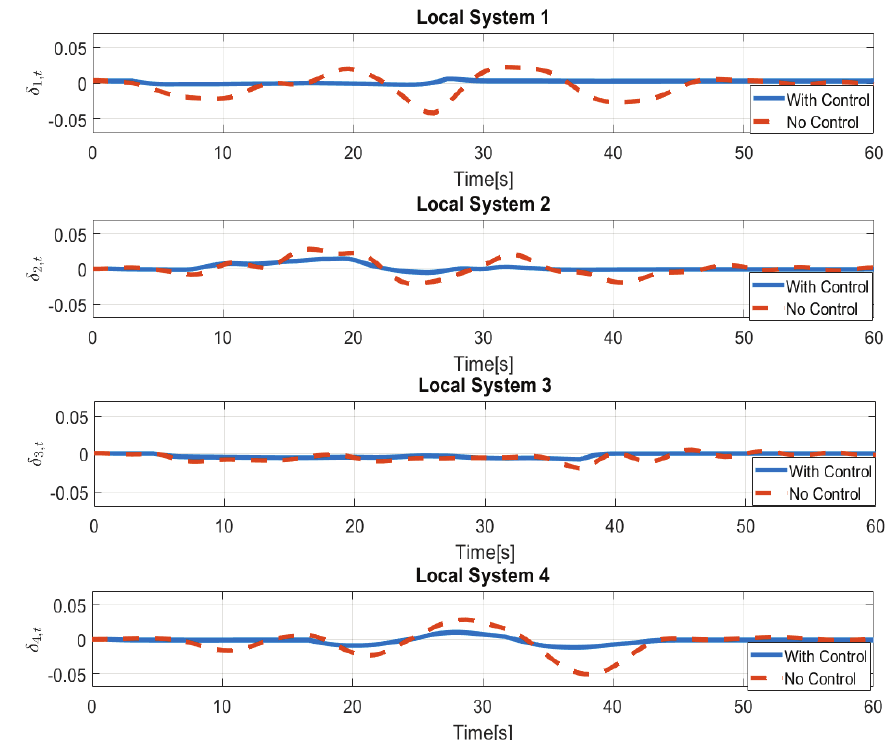
Figure 6. Phase optimal results at each local system.